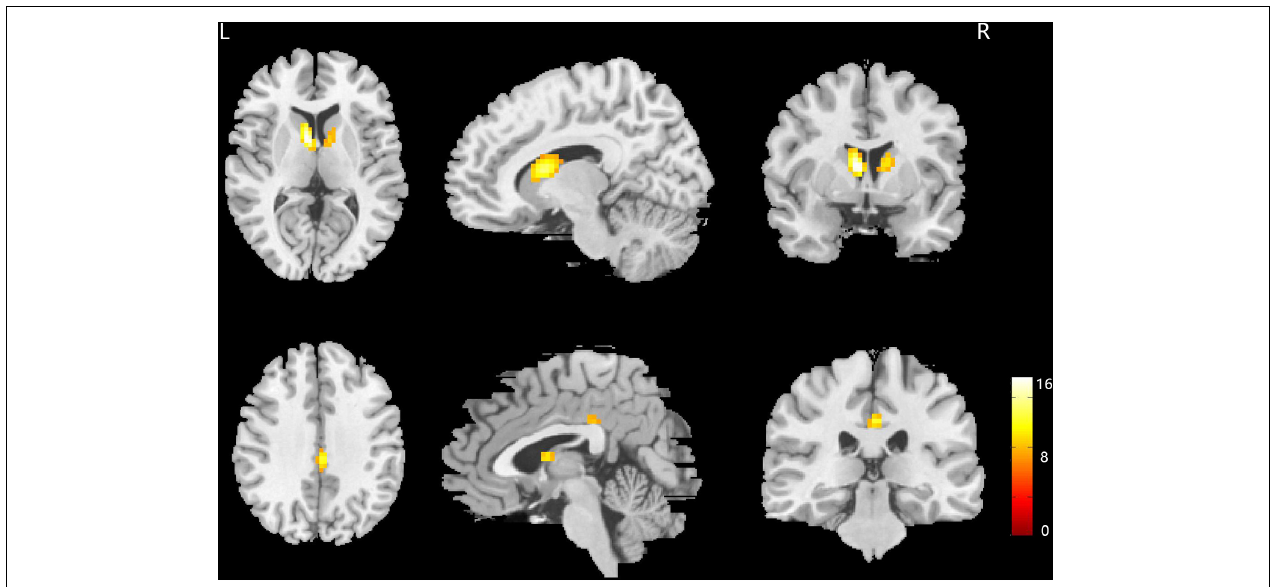
FIGURE 1 | Brain regions showing the main effect result of amplitude of low-frequency fluctuation (ALFF) differences between male and female major depressive disorder (MDD) patients. p < 0.05, family wise error (FWE) corrected. TABLE 2 | Brain areas with significant amplitude of low-frequency fluctuation (ALFF) differences between the four groups of subjects. Brain regions Brodmann areas MNI coordinate Cluster size F-value x y z Left caudate nucleus − 9 163 16.37 Right caudate